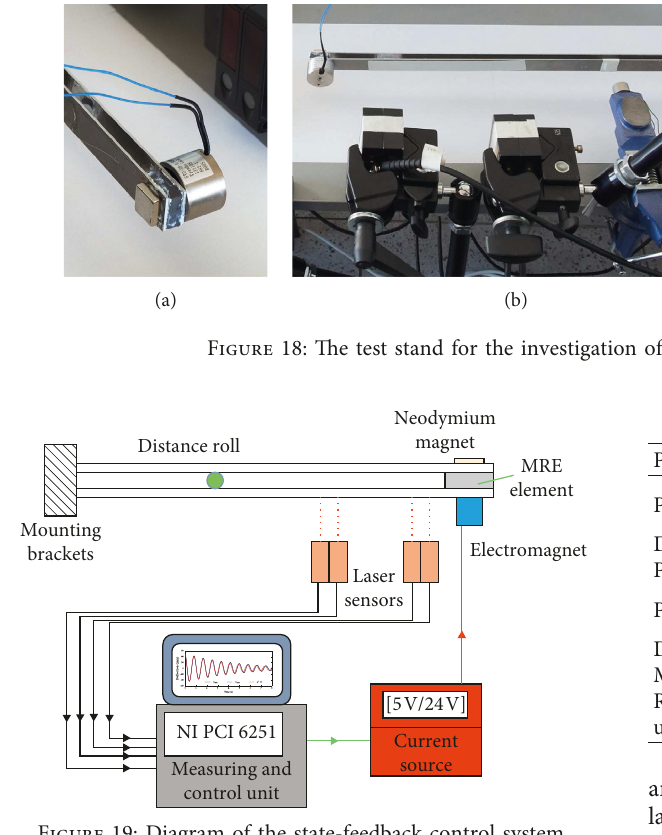
Figure 19: Diagram of the state-feedback control system.